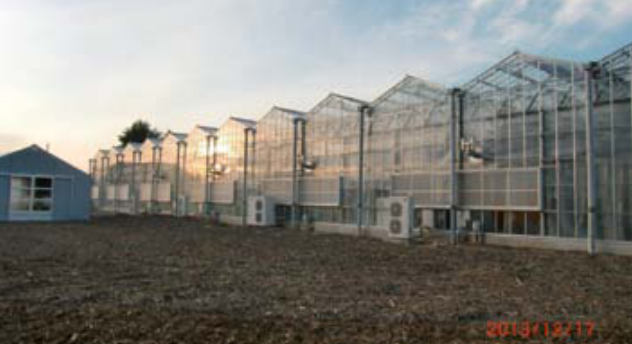
Fig. 5 - A multi-span type glasshouse with small roofs constructed in Tsukuba City, Ibaraki